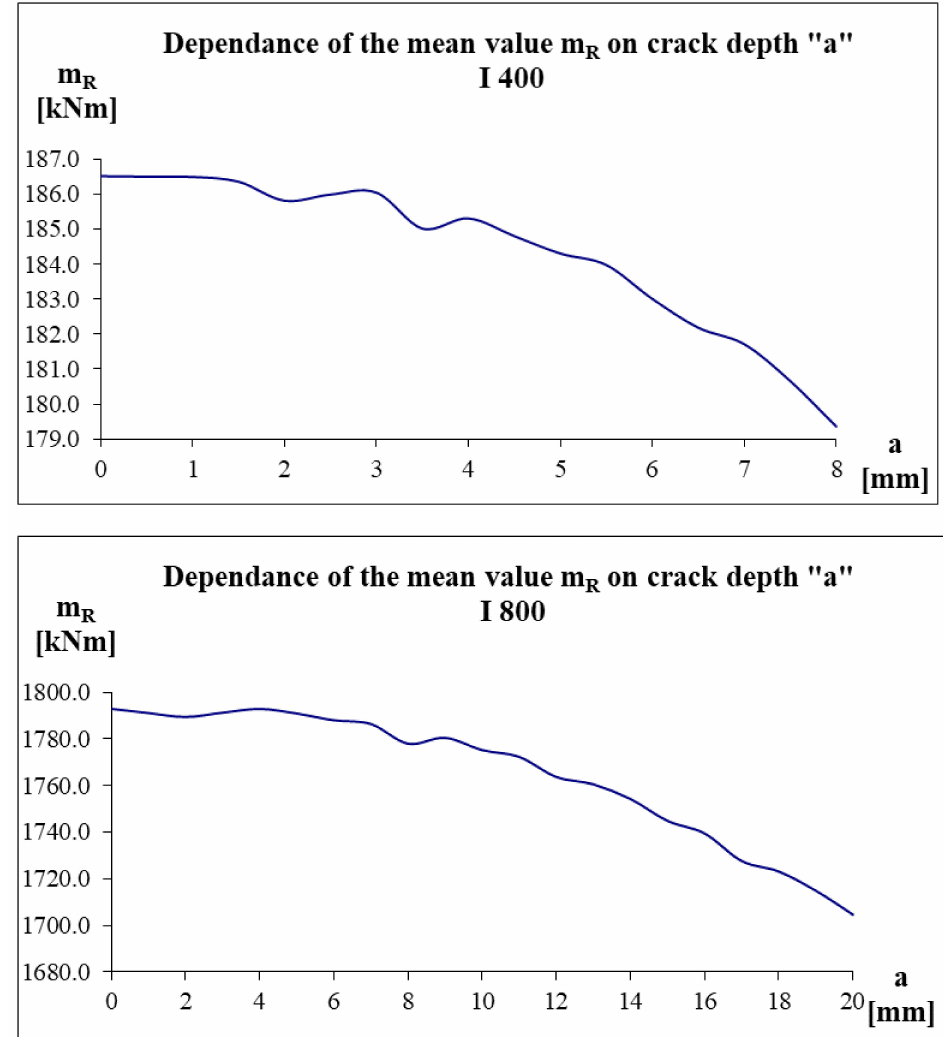
Figure 12. Dependence of resistance mean value m R on crack depth “a”.